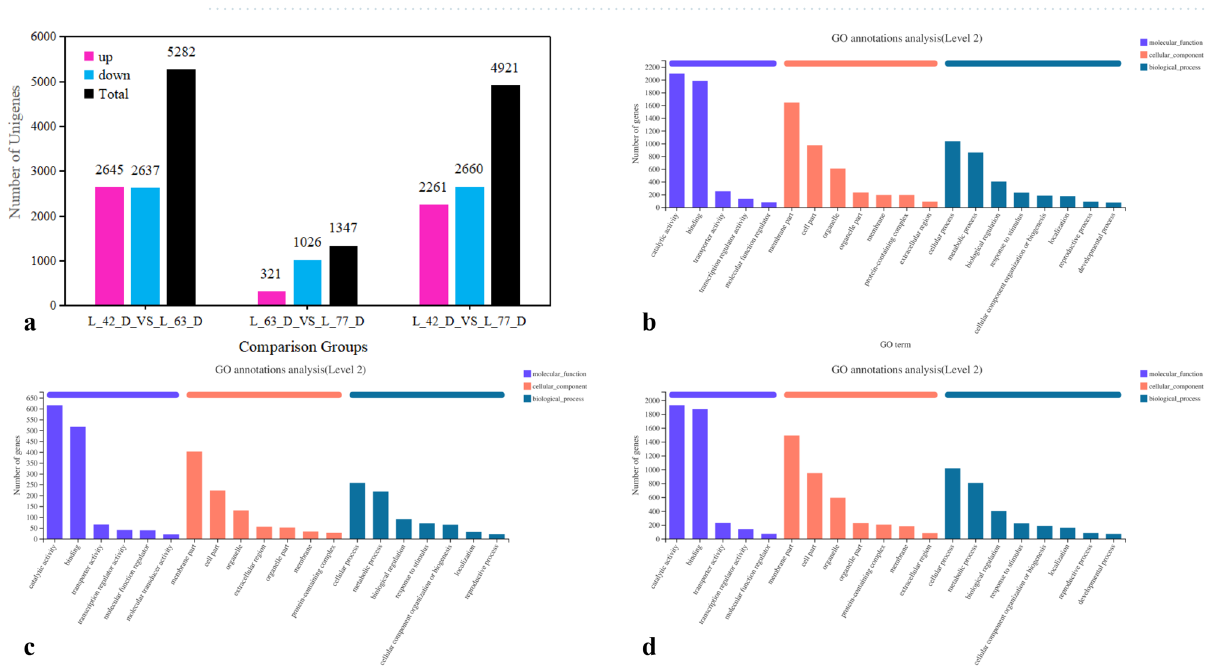
Figure 6. Numbers of up- and down-regulated DEGs and their functional annotation among 3 stages of “Luntaibaixing”